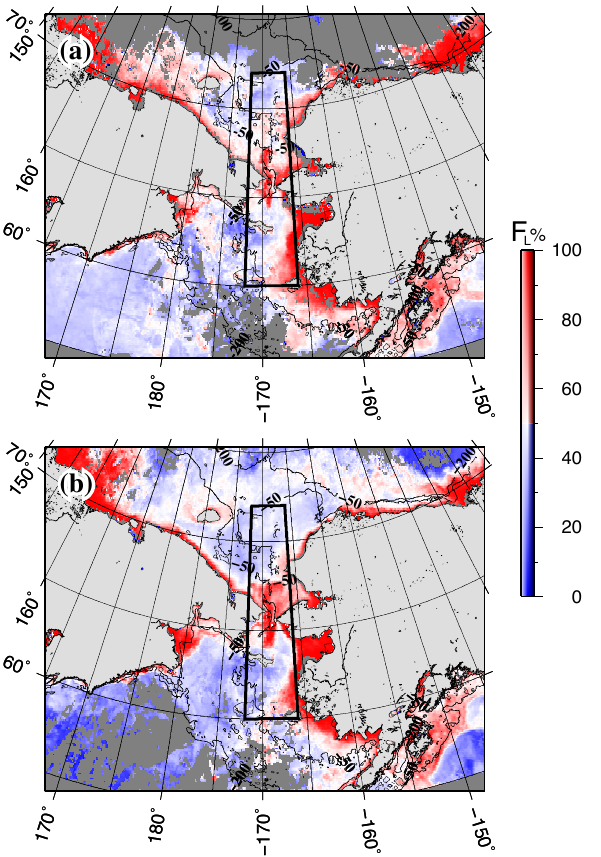
Fig. 4. Satellite-retrieved map of monthly composited F L in the study region for (a) August 2006 and (b) August 2007. Gray indicates the invalid pixels according to the presence of clouds or sea ice. Frames located at 60–72 ◦ N, 166–172 ◦ W indicate the area for which statistical analysis was performed (Table 5, Fig. 5) for F L , chl- a and SST. Bathymetry contours indicated are 50- and 200-m intervals.